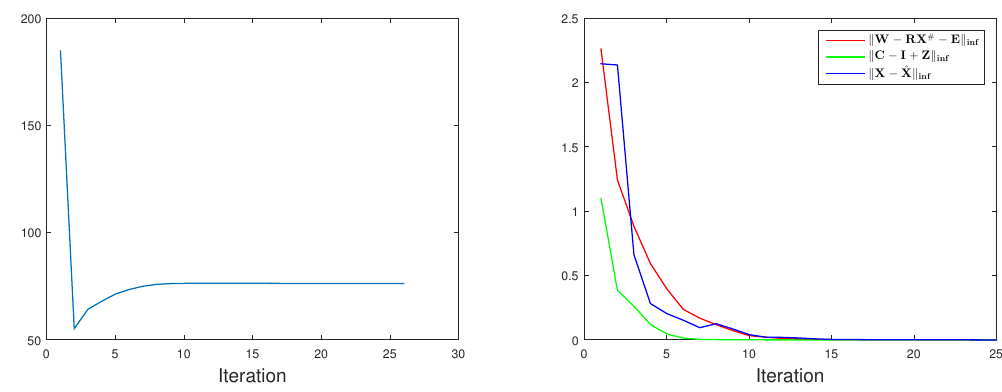
Figure 1. Convergence curve. We test our TUNS method on ’56-02’ sequence in CMU MoCap datasets is used here. We plot the residual of the objective function ( left ) and the residuals of three constraints ( right